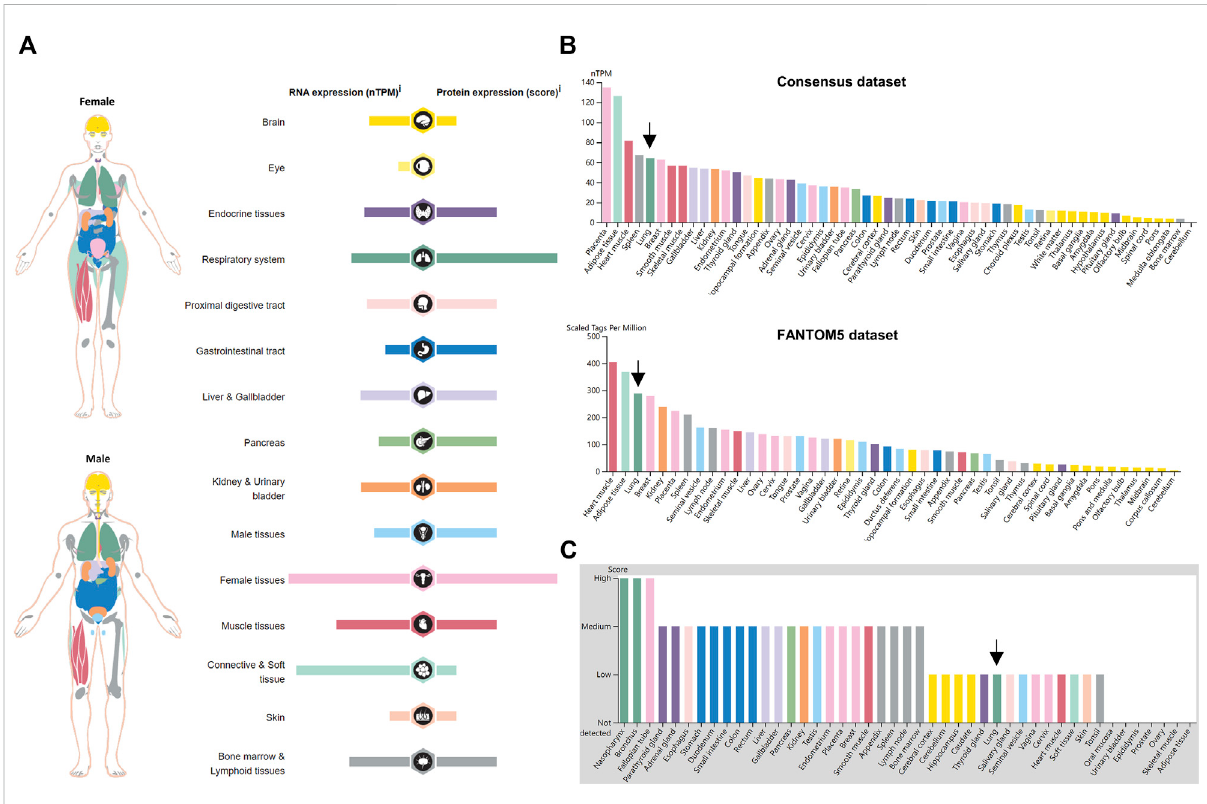
NRP1 expression in normal human tissues (A) The expression and distribution features of NRP1 in normal human tissues. (B) The mRNA expression pro fi le of NRP1 in the Consensus dataset and FANTOM5 dataset ranked by expression levels. (C) The protein expression pro fi le of NRP1 ranked by expression levels. Arrows indicated lung